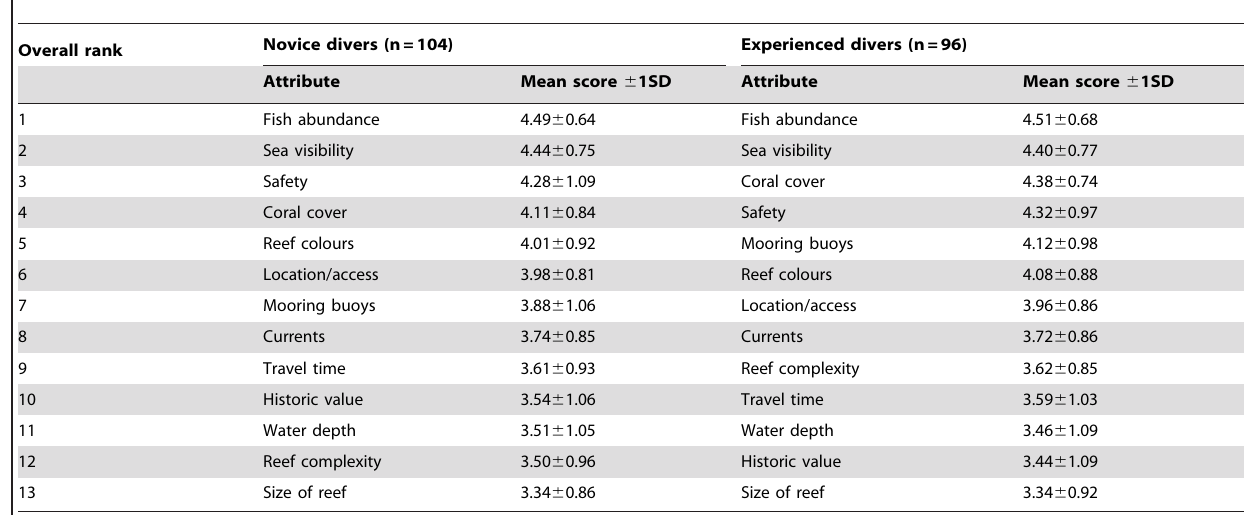
Table 2. Ranked mean scores relating to the importance of artificial reef attributes for novice divers and experienced divers.